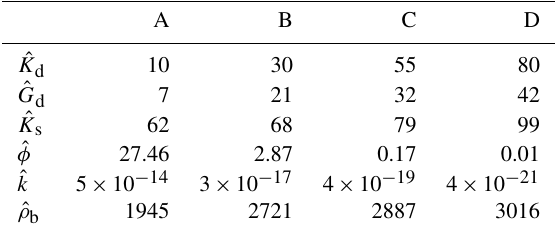
Table 1. Intact-rock properties for the four lithologies A, B, C, and D. Elastic moduli ˆ K d , ˆ G d , and ˆ K s are given in GPa, porosity ˆ φ in %, permeability ˆ k in m 2 , and bulk density ˆ ρ b in kgm − 3 .